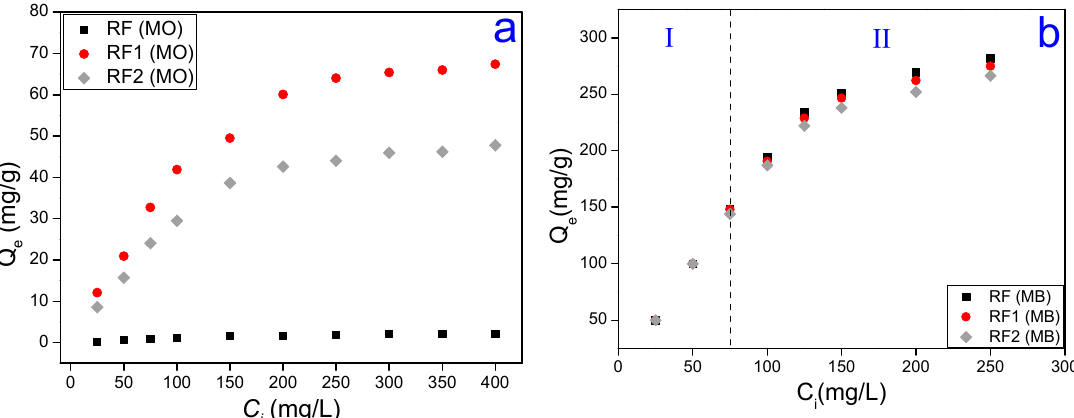
Figure 4. The amounts adsorbed of the MO ( a ) and MB ( b ) dyes for different initial concentrations of the adsorbate.